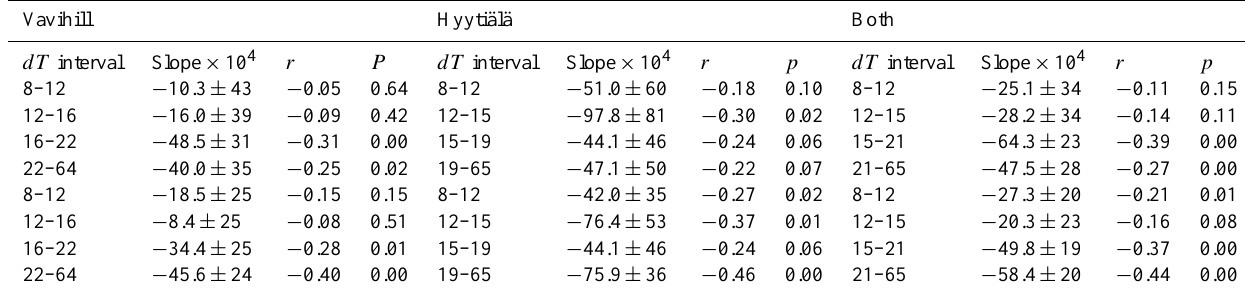
Table 5. Slopes of trend lines in Fig. 8 ± the 95 % confidence intervals of the slopes, correlation coefficients and p values for the dT intervals ( ◦ C) in Fig. 8. The non-shaded part of table is values for the dataset including zero-values of dbcz and shaded part of table are for the dataset without zero-values of